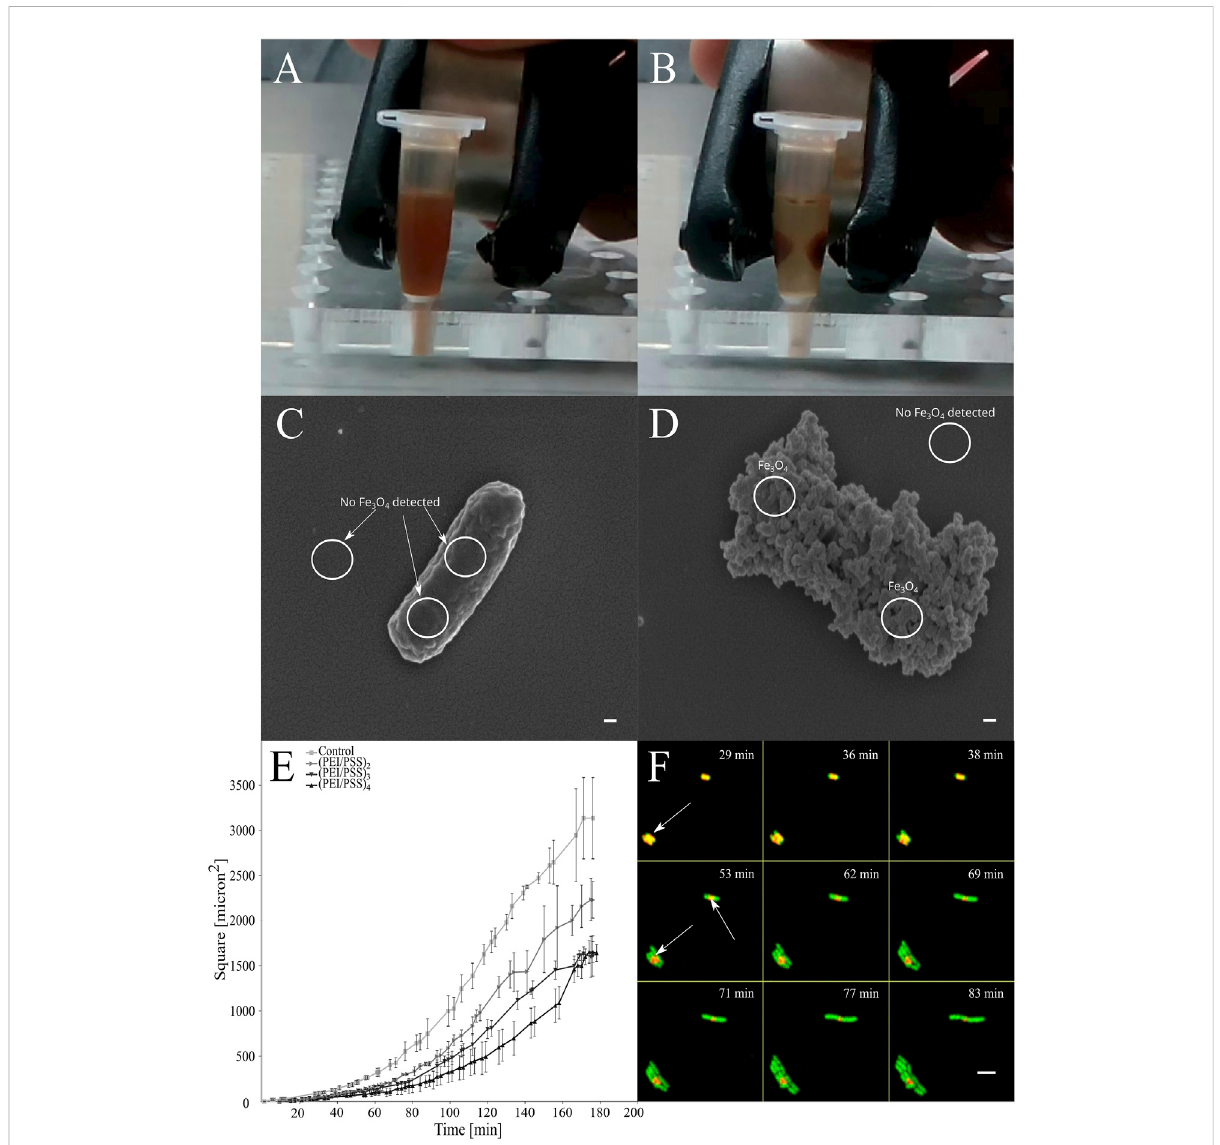
FIGURE 1 In vitro magnetic entrapment of the E. coli cells coated by PEI)/(PSS)/PEI/Fe3O4. PEI = polyethylenimine, PSS = poly (styrene)sulfonate. (A,B) When a magnetic fi eld is applied, movement occurs instantly. (C,D) Presence or absence of nanoparticles was con fi rmed by SEM (EDS), where cells thatarecoveredwiththePElayerswheremagnetitenanoparticles areincorporatedinbetweenthelayersareshowingaroughsurfaceandpresence of Fe, scale bars = 100 nm. (E) Effects of entrapment of cells in layers of polyelectrolytes on growth of the population of the individually coated bacterialcells.Growthrateisshowedasthefunctionofthecoverageofthesurfacebybacterialcellsintimeaccordingtotheanalysisofmicrographs obtained with TLCM (see methods). (F) Escape of the cells from the LbL layers when entrapped in polyelectrolyte layers. The LbL capsule is red, indicated with arrows, GFP producing cells are green and overlap regions are yellow. Scale bar = 5